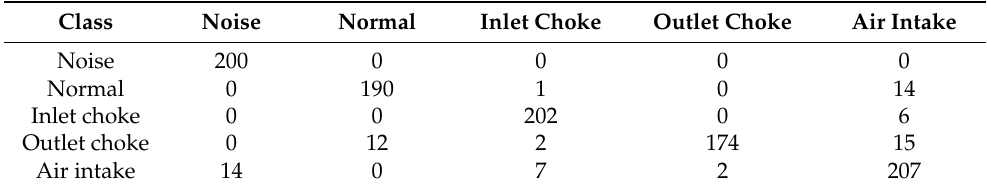
Table 2. The confusion matrix corresponding to the trained neural network model, created by classifying approximately 200 episodes for each